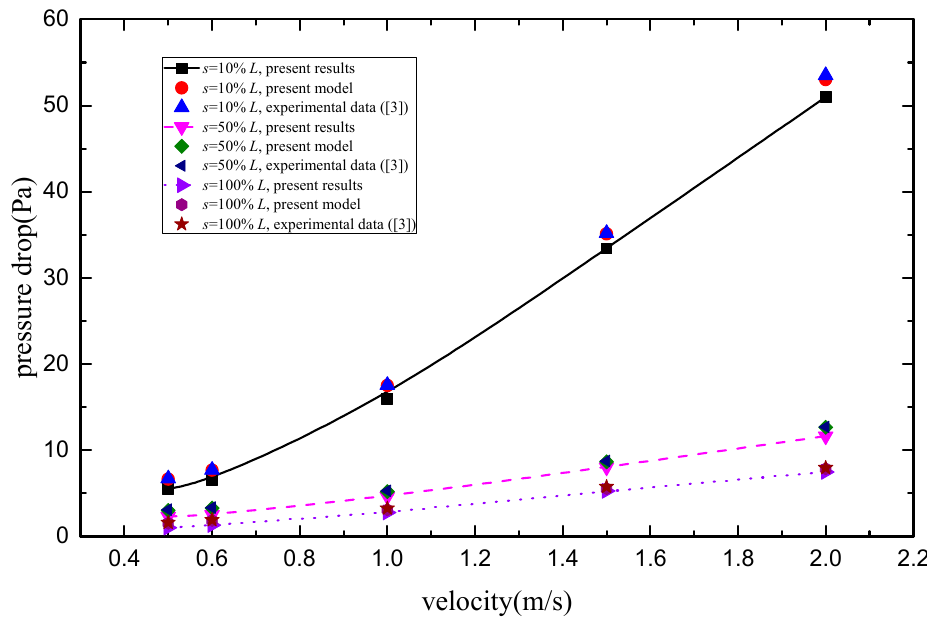
Figure 8. Comparisons of the pressure drop for the #1 plate fin heat sink.